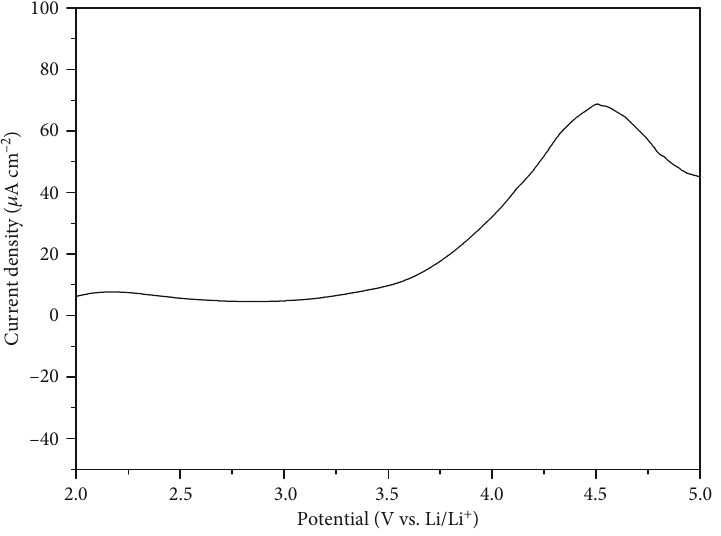
Figure 6: Linear sweep voltammogram of GPE@PVDF T (lithium transference numbers) compared to the calculated to 1 : 4 × 10 − 3 S cm − 1 from Figure S6. Values of Li+ pure PVDF membrane. initial and steady-state currents (I , I ), and interfacial 0 S resistances (R , R ) of symmetric Li/Li + cells with the 0 S GPE@PVDF membrane were evaluated by polarization curves and impedance spectra as shown in Table S3 and Figure S7. It is believed that GPE@PVDF possesses better